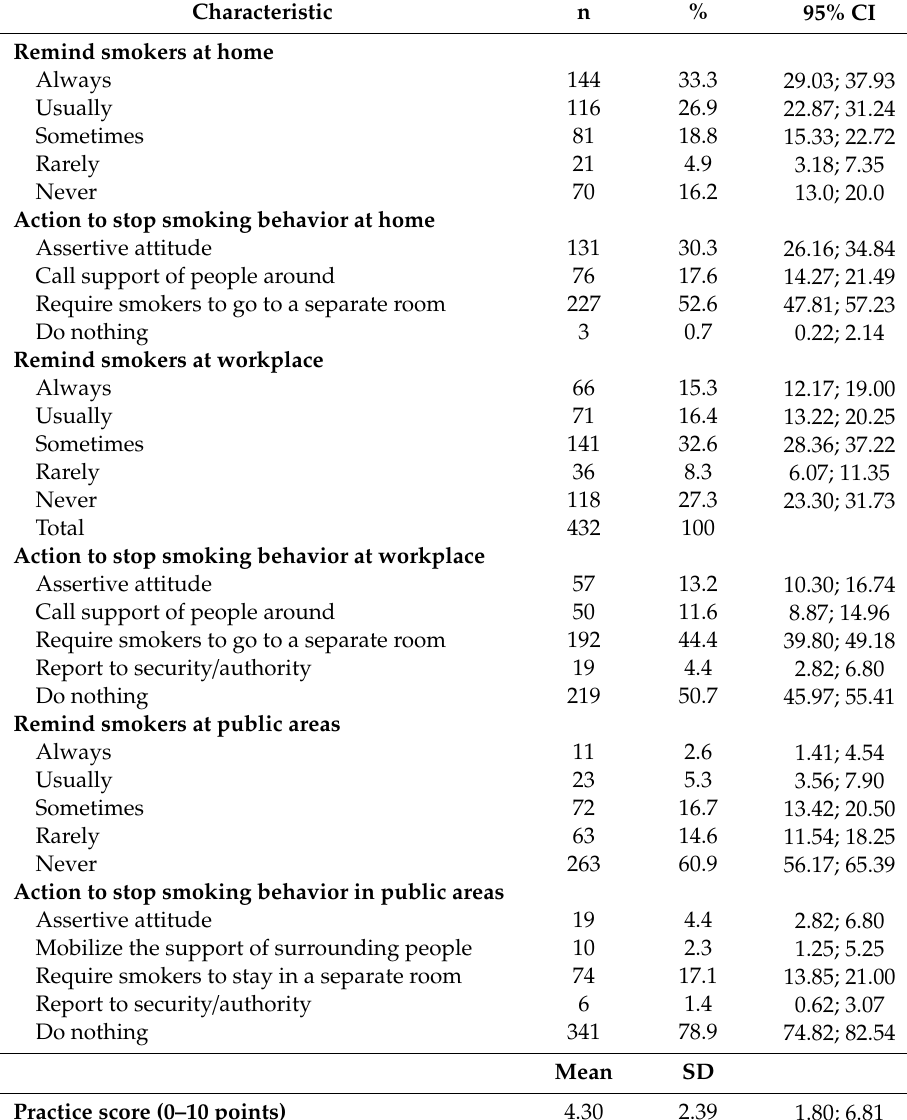
Table 4. Practice about